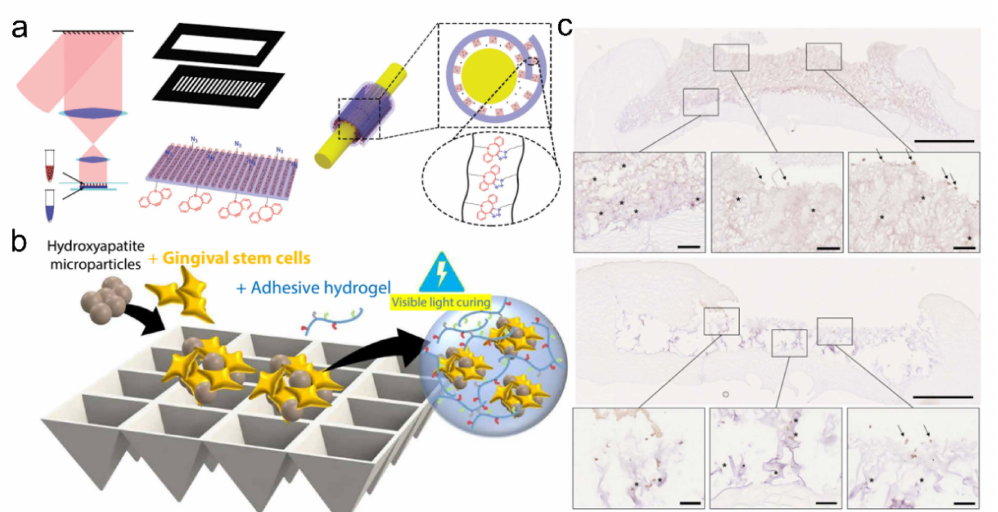
Figure 8. ( a ) A self-adhesive drug-loaded bandage showed the ability of directional and continuous releasing of the nano-drugs to specific locations. ( b ) Schematic of the forced aggregation process to prepare gingival MSCs and hydroxyapatite (HA) aggregates. Reproduced with permission [106]. Copyright 2020, American Association for the Advancement of Science. ( c ) HA-DOPA showed suitable proliferation and cellular morphology, which could serve as an effective cell vehicle for corneal regeneration. The higher magnification images showed encapsulated cells (*) and cells on the surface of the implant (arrows). The circle represents the surface of hydrogel implants. Scale bars in the whole cornea images are 1 mm, and 100 µ m in the insets. Reproduced with permission [97]. Copyright 2019,